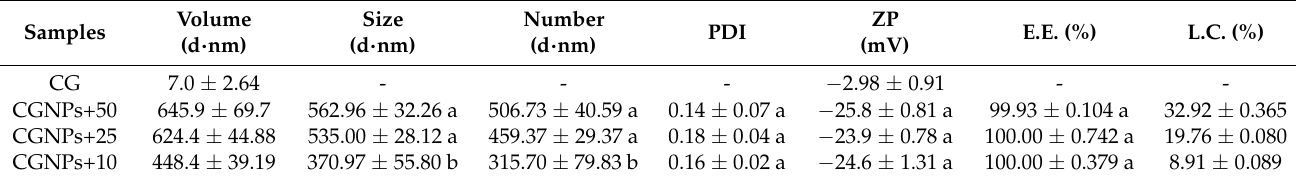
Table 1. Analysis of the size, polydispersity index, zeta potential, encapsulation efficiency, and loading capacity of cashew gum particles with different concentrations (50%, 25% and 10%) of α -Tocopherol. Samples